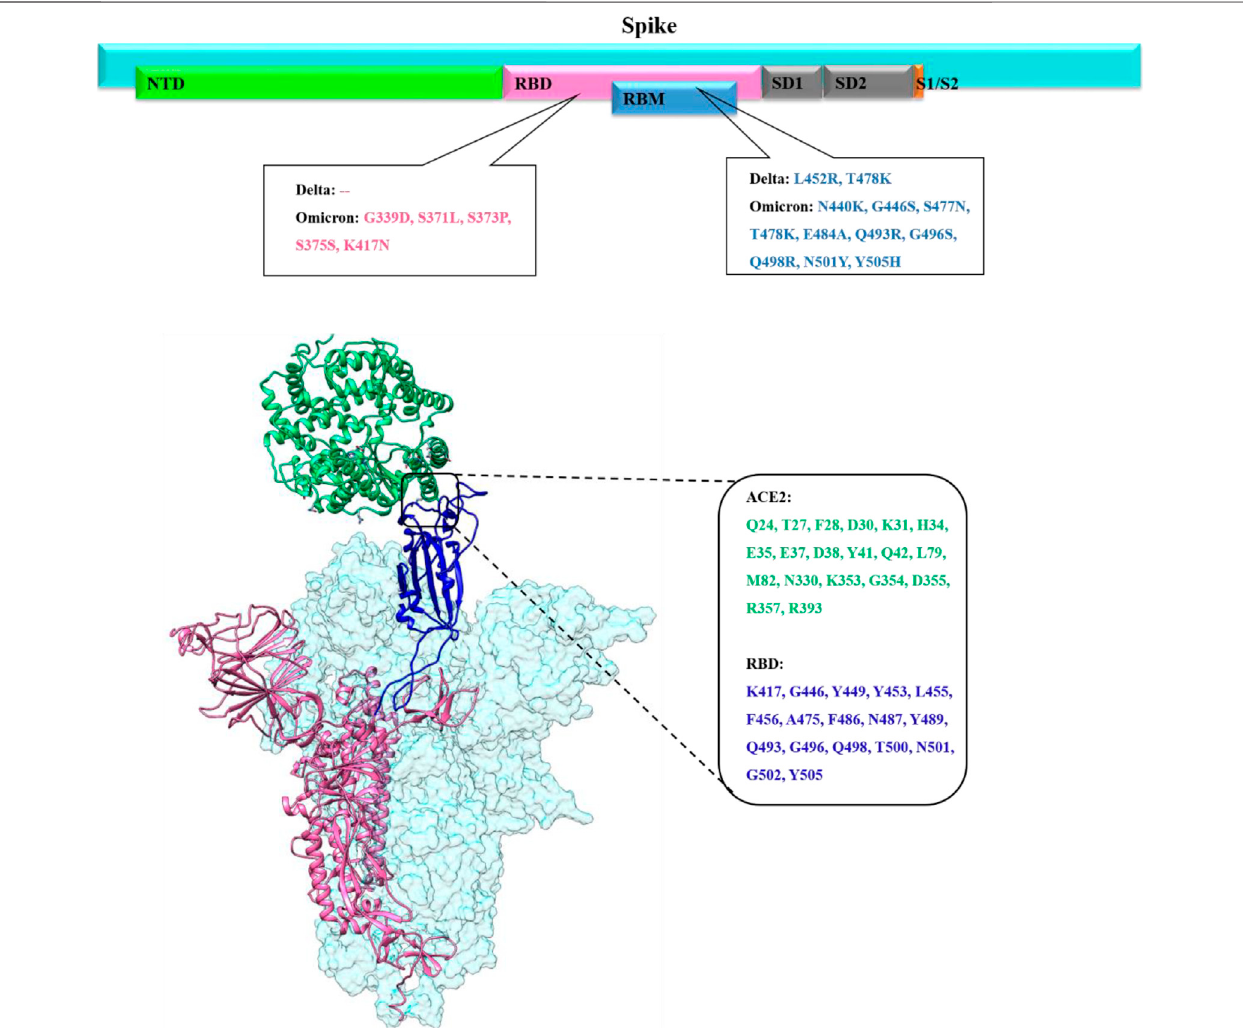
FIGURE1| UpperpanelshowstheoverallprimarystructureofthespikeproteinofSARS-CoV-2shownincyancolorwhileeachdomainisshownindifferentcolors (N-Terminal domain (NED) in light green, receptor binding domain (RBD) in pink, receptor binding motif (RBM) in blue, subdomain 1 and subdomain 2 in gray, subunit1/ subunit2 site in orange color with impactful mutations in Delta and Omicron. The lower panel presents the binding mode and interfacial residues between RBD (up conformation) of the spike monomer with the host ACE2 receptor.